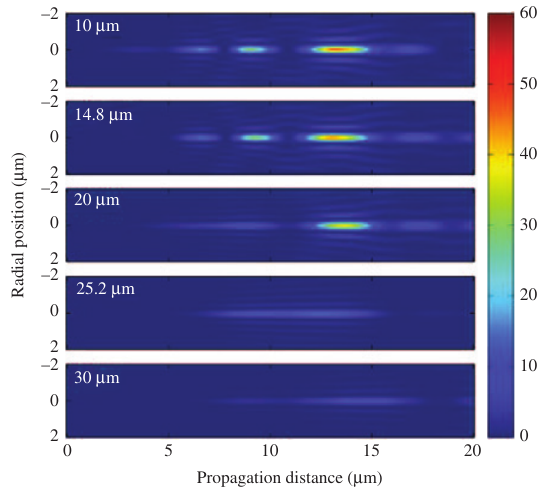
Figure 9: The simulations of the field of an optical needle superoscillatory lens for various diameters of the blocking region, for a beam with wavelength 640 nm and a 40 μ m diameter SOL overall. After [36].